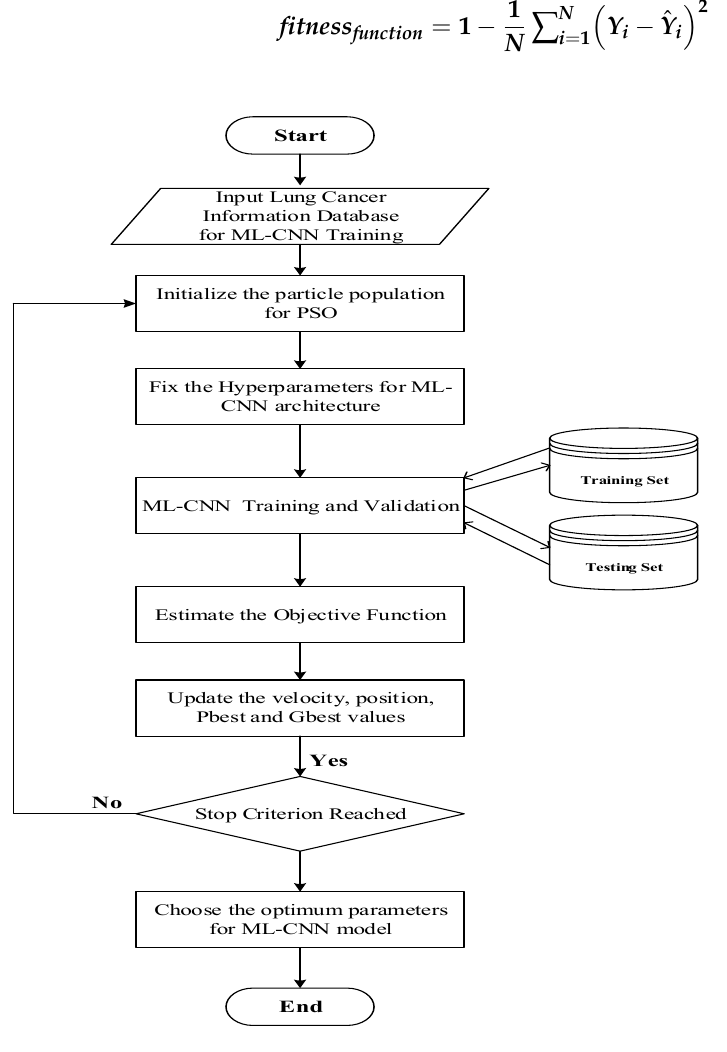
Figure 4. Flowchart for CNN with PSO.